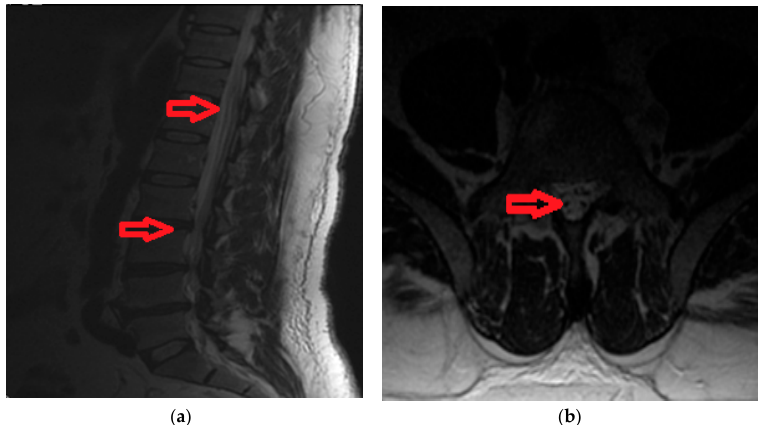
Figure 2. ( a ). Magnetic Resonance Imaging findings include hyperintensities on T2 ‐ SAG ‐ FRFSE (T2 ‐ weighted Sagital Fast Recovery Fast Spin Echo) images with gadolinium enhancement at T10 ‐ L2 levels and herniated disk L2. ( b ) Magnetic Resonance Imaging reveals a double ‐ dot (“owl’s eyes”) pattern in the region of the anterior horns of spinal cord on T2 ‐ Ax ‐ FRFSE (T2 ‐ weighted Axial Fast Recovery Fast Spin Echo).